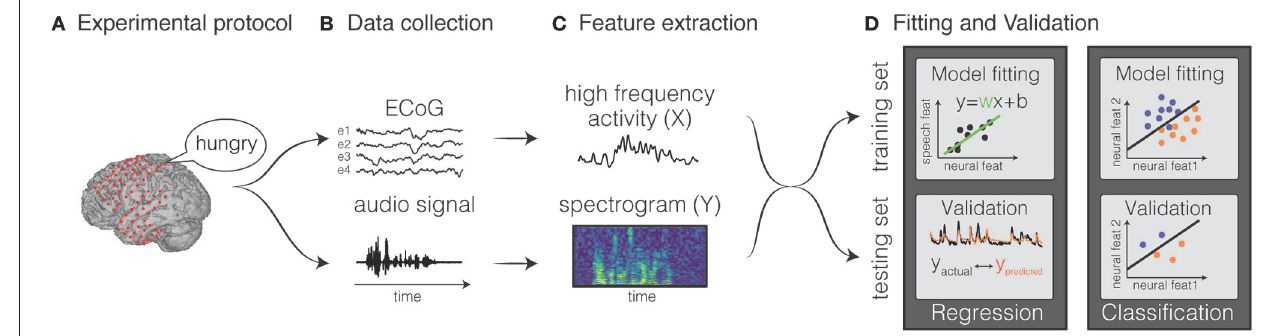
FIGURE 2 | Decoding framework. The general framework for fitting a decoding model is depicted. The first step consists in designing a protocol (A) and recording the data (B) . Then, input and output features are extracted (C) , and the data are split in training and testing set. The training set is used to fit the weights of the model and the testing set is used to validated the model (D) . Figures adapted from Holdgraf et al. (2017) with